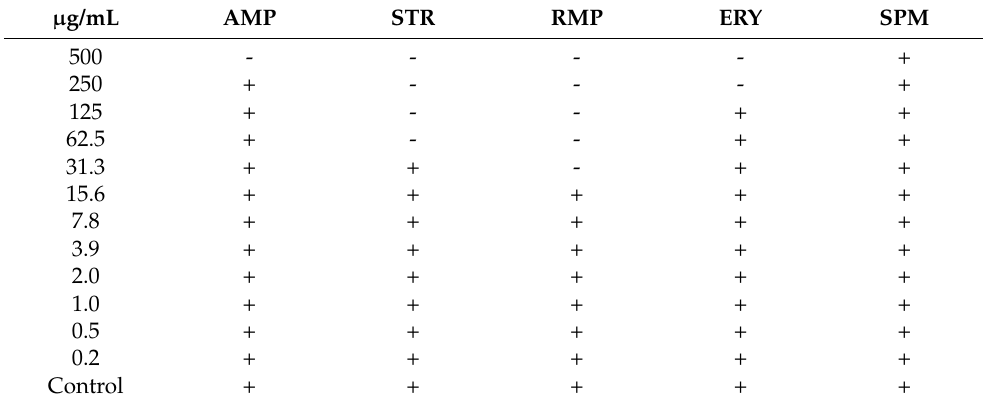
Table 1. MIC experiments: susceptibility of P. aeruginosa GG-7R at different antibiotics tested. µ